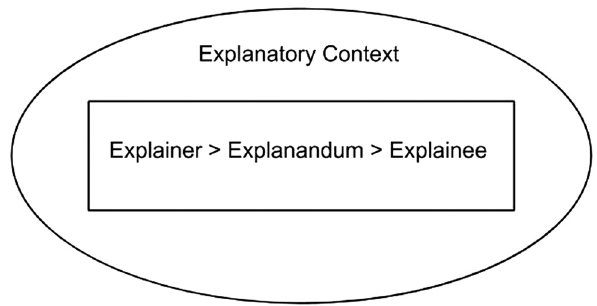
Figure 2. It is within this context that explanations function as a tool people use to manage communica - tion, in fl uence, impressions and persuasion with each other [ 32,51 ]